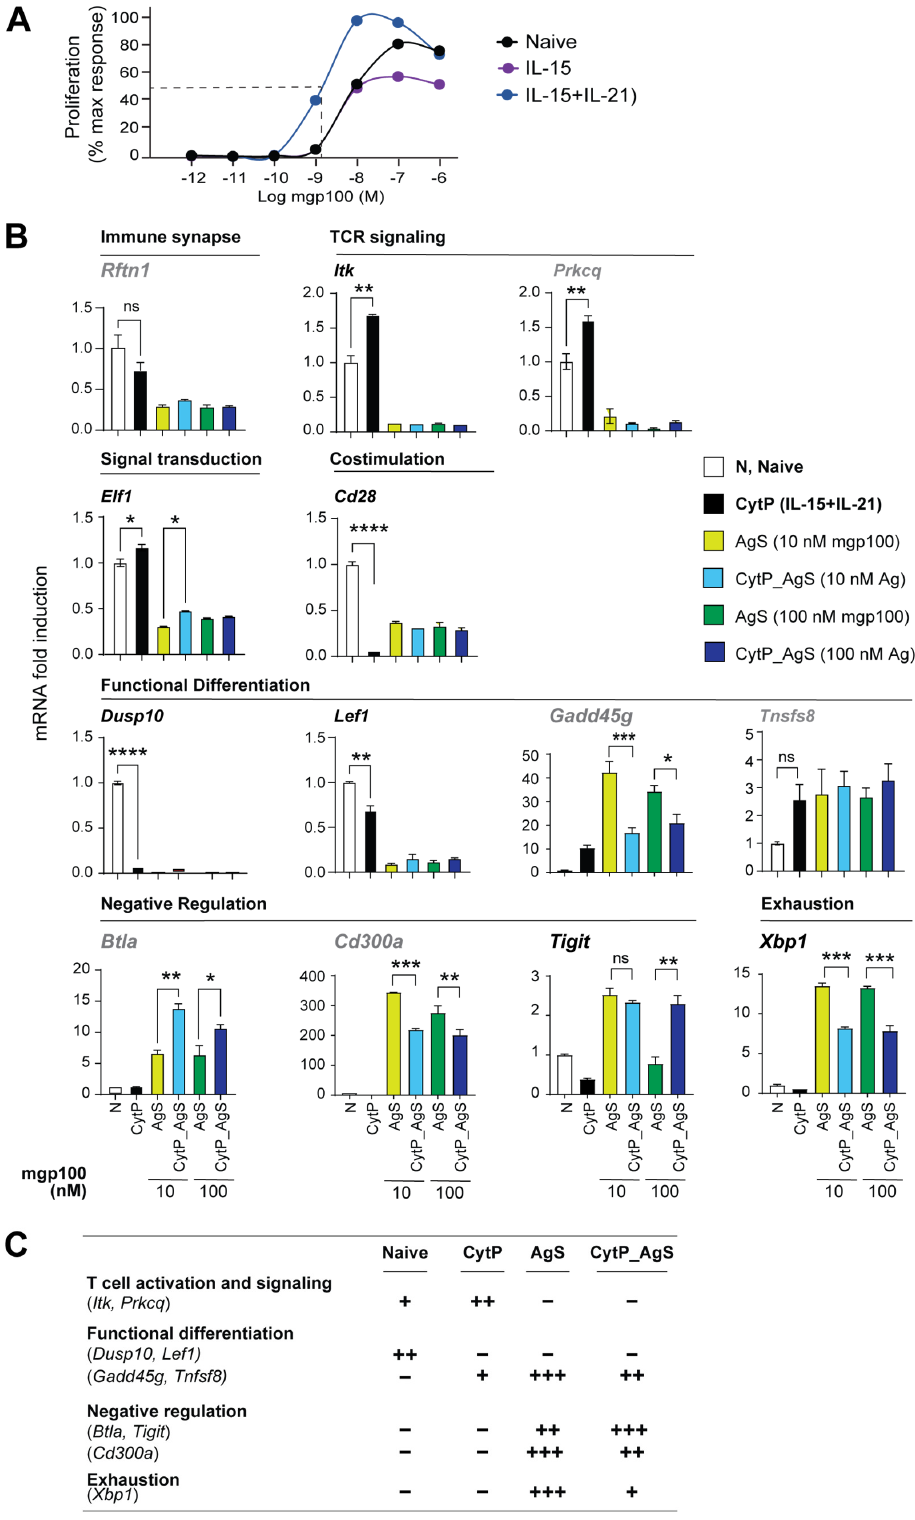
Figure 7. Expression of T cell activation genes in CytP and AgS cells. ( A ) Increased Ag sensitivity of naïve CD8 + T cells following cytokine priming. PMEL-1 naive CD8 + T cells were stimulated with IL-15 or IL-15+IL-21 for 48 h prior to stimulation with indicated concentrations of the cognate Ag pep- tide for 48 h. Cell proliferation was assessed by [3H]-thymidine incorporation and expressed % of